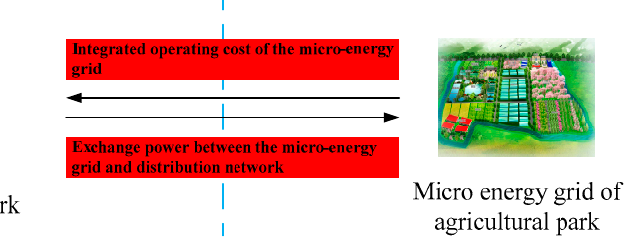
Figure 3. Bi-level optimization model.